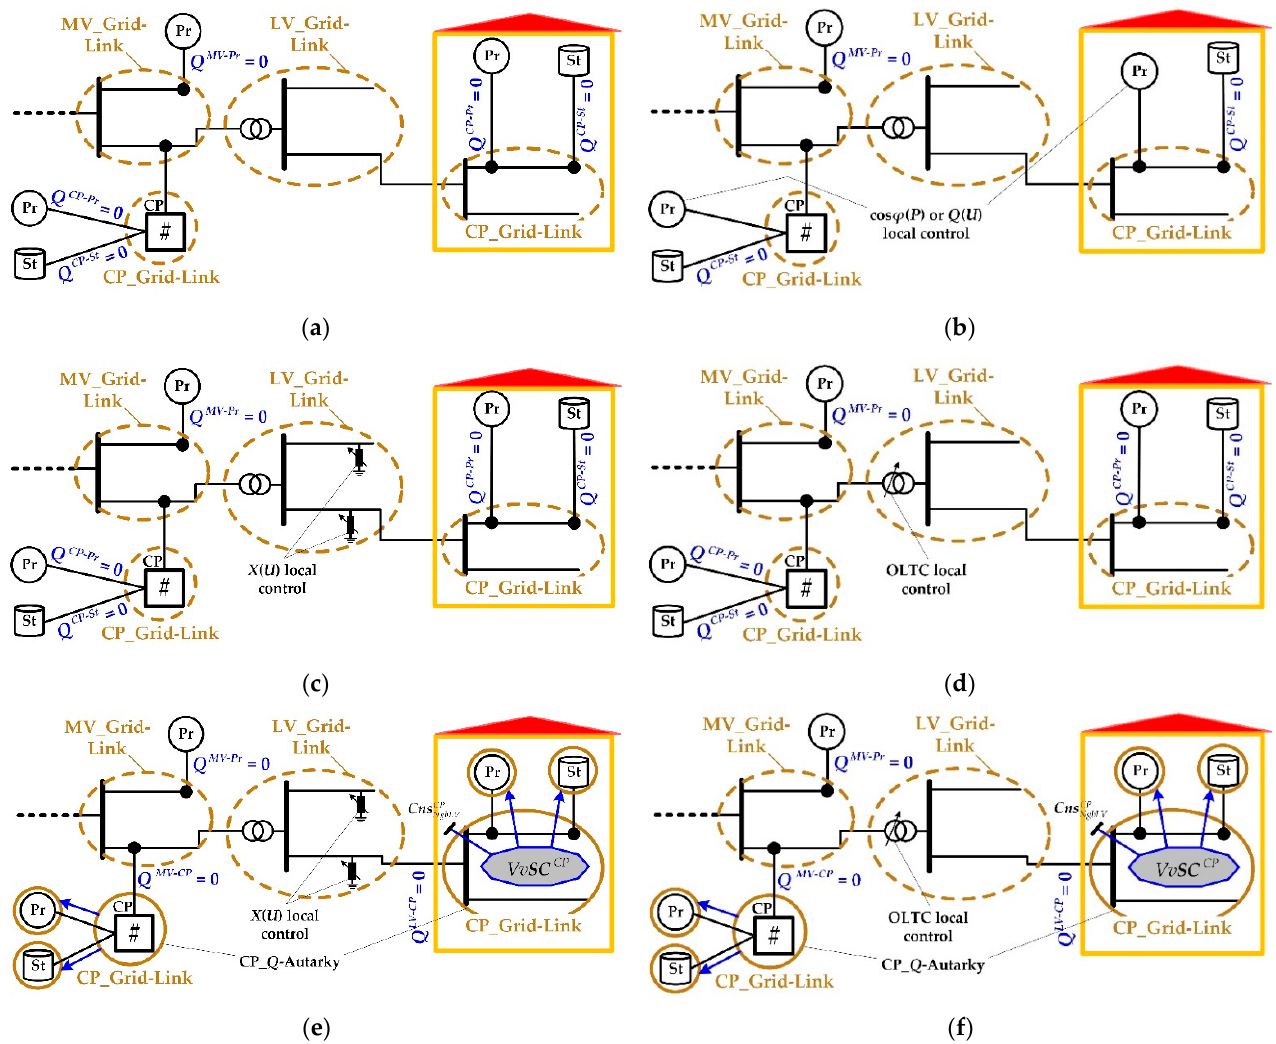
Figure 6. Overview of different Volt/var control arrangements: ( a ) no control; ( b ) cos φ ( P ) or Q ( U ) local control; ( c ) X ( U ) local control; ( d ) OLTC local control; ( e ) X ( U ) local control and CP_ Q -Autarky; ( f ) OLTC local control and CP_ Q -Autarky.